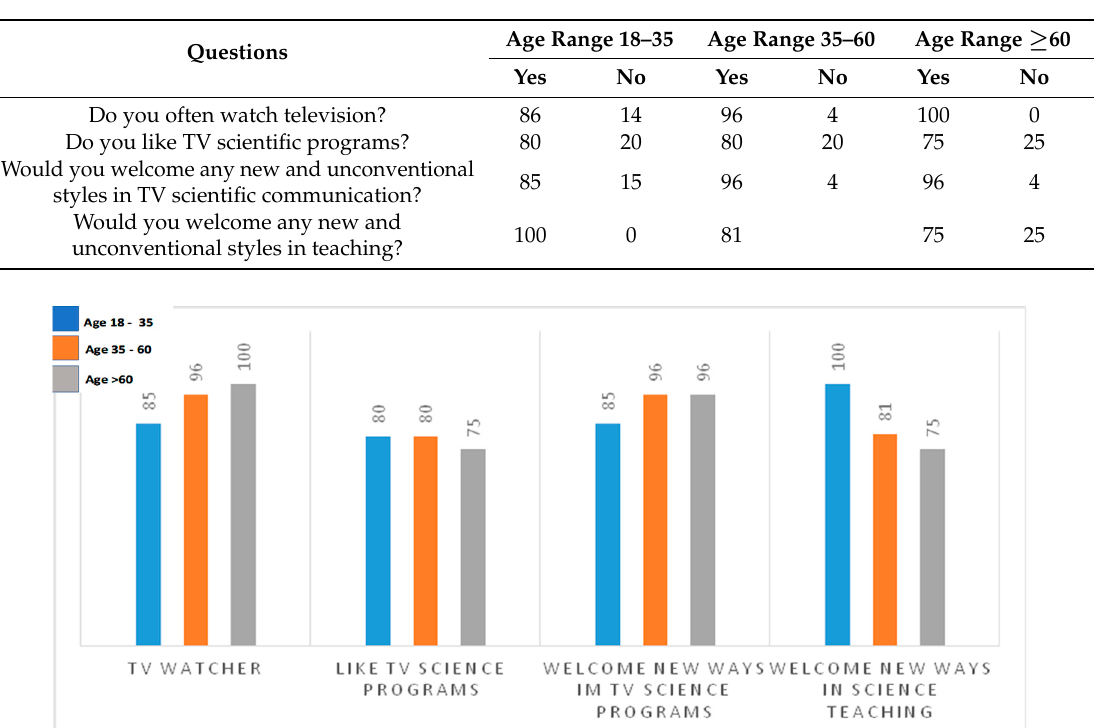
Figure 5. Diagram of personal approach to TV programs.